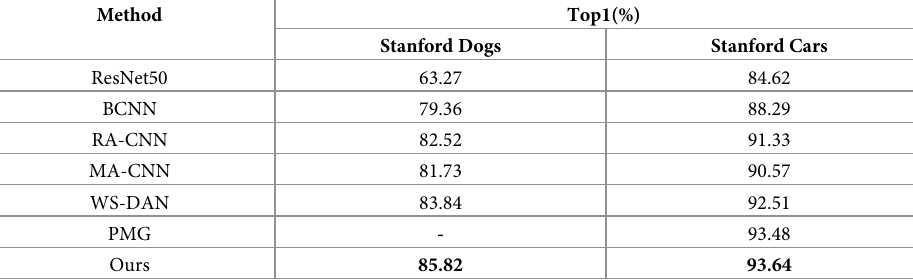
Table 6. Comparison results on Stanford Dogs and Stanford